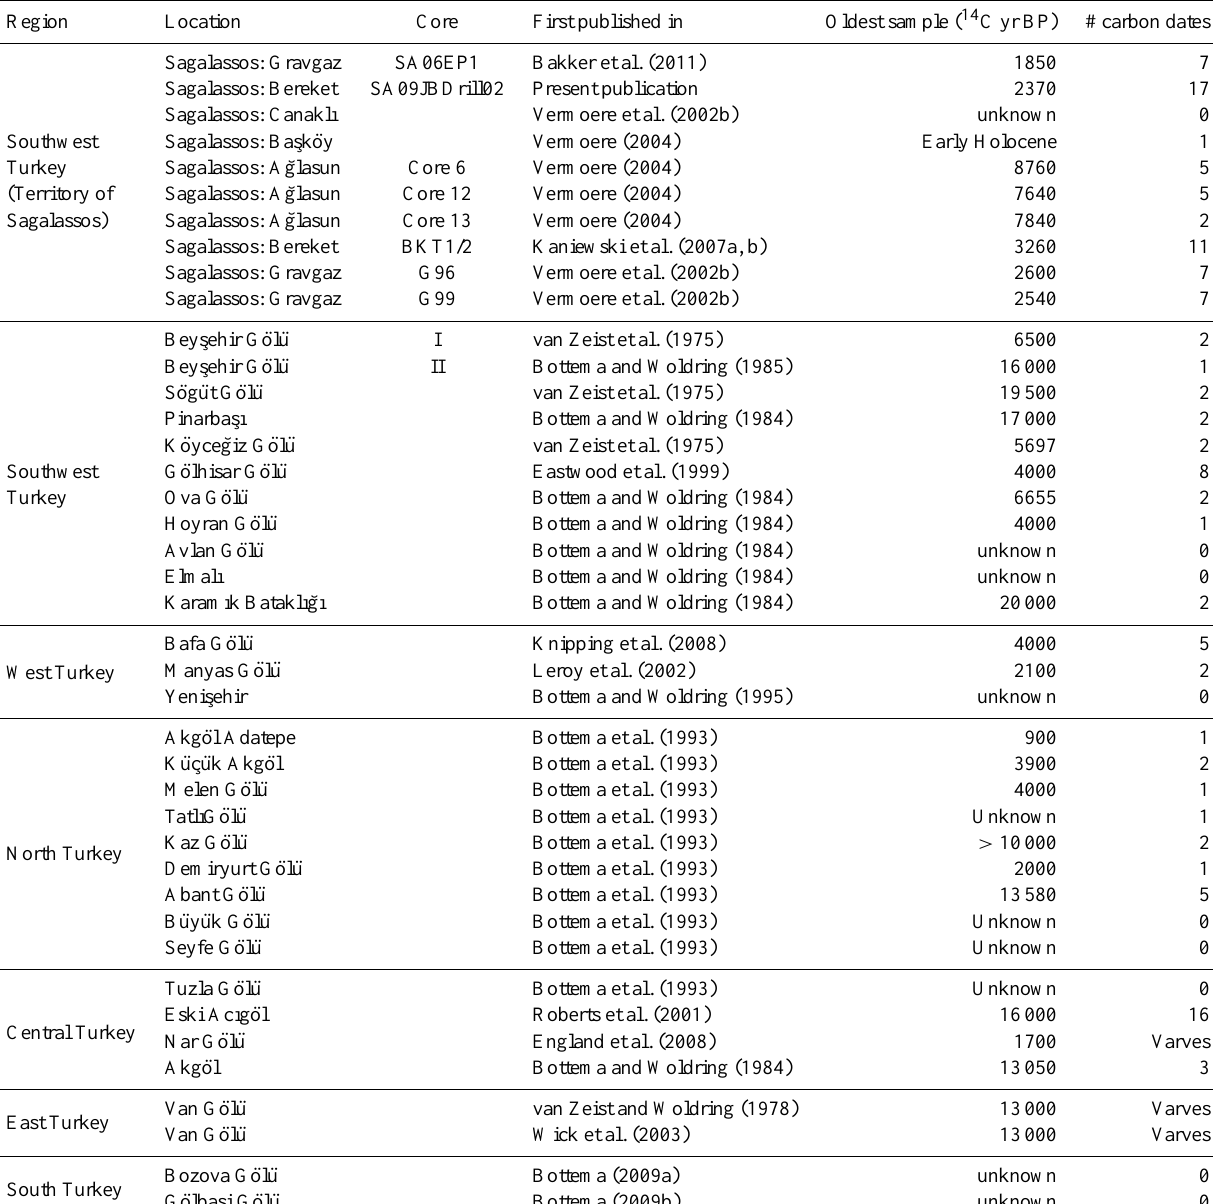
Table 1. The main characteristics of a selection of palynological records from Turkey.